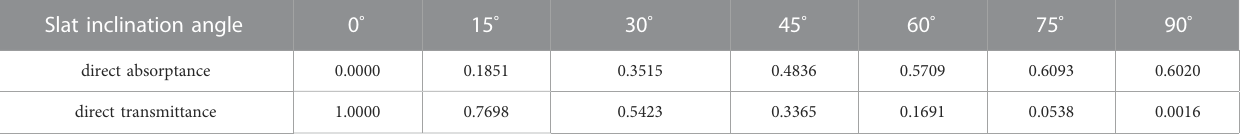
TABLE 3 Summary of direct absorptance and direct transmittance, for different slat inclination